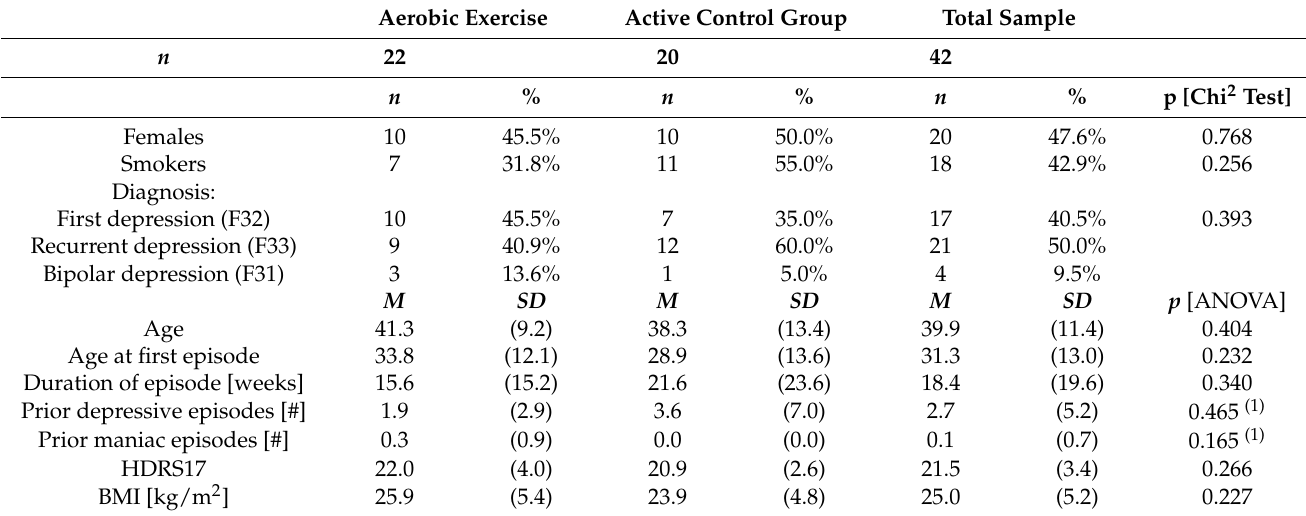
Table 1. Sample description at